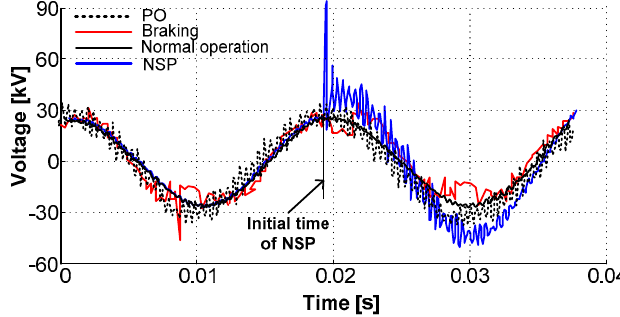
Figure 4. The voltage measured in the neutral line of LV side of a traction substation transformer.